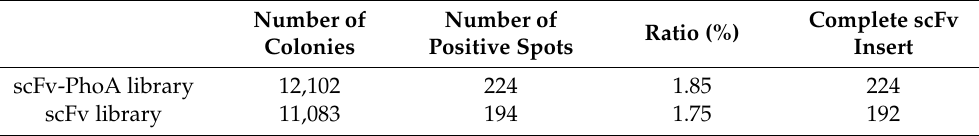
Table 1. Quantitative analysis of the colony-assay. E. coli were transformed with the scFv-PhoA and scFv libraries, and bacteria were spread on 10 plates (3 × 10 3 bacteria per plate). Colonies growing on the filter and spots corresponding to the positive clones on the antigen-coated membrane were counted. The number of colonies that had full-length scFv inserts was determined by colony